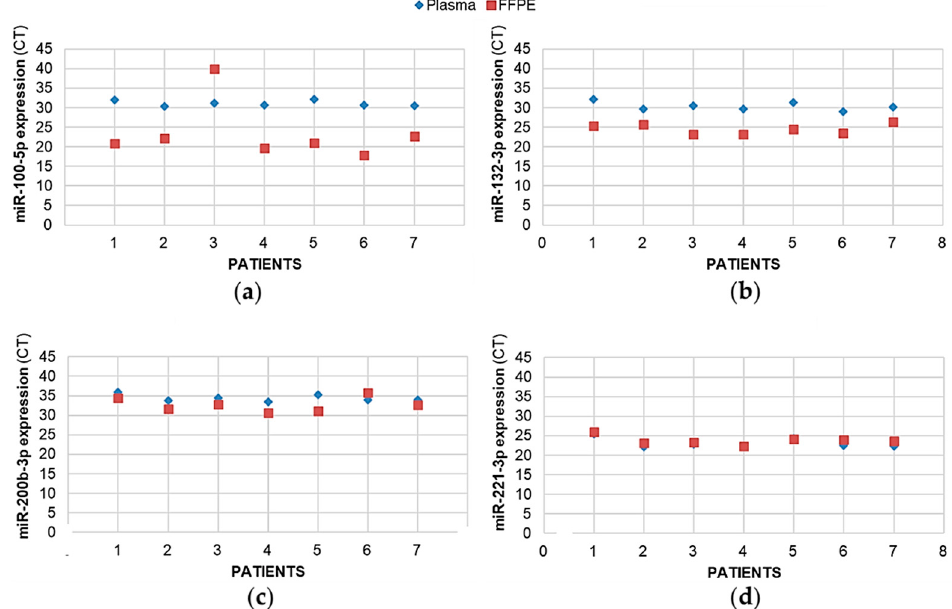
Figure 5. The expression levels of pro-angiogenic or pro-hypoxic miRNAs were correlated between the tumor sample and plasma from patients with glioma. For 7 patients with glioma, the miRNAs from the FFPE surgically resected tumor specimens or the plasma samples were extracted using, miRNAeasy-FFPE kit (Qiagen™) and NucleoSpin miRNA Plasma (Macherey-Nagel™),